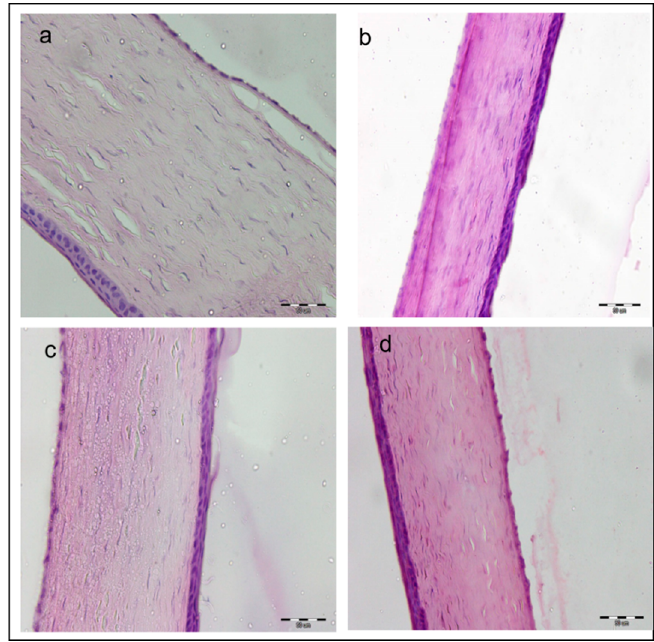
Figure 7. Histopathologic evaluations of rabbit corneas after 14 days of twice daily administration of ( a ) normal saline, ( b ) CsA-NE, ( c ) CsA in castor oil and ( d ) 0.1% CsA-LNC-CP in situ gel . scale bar 50 µm.